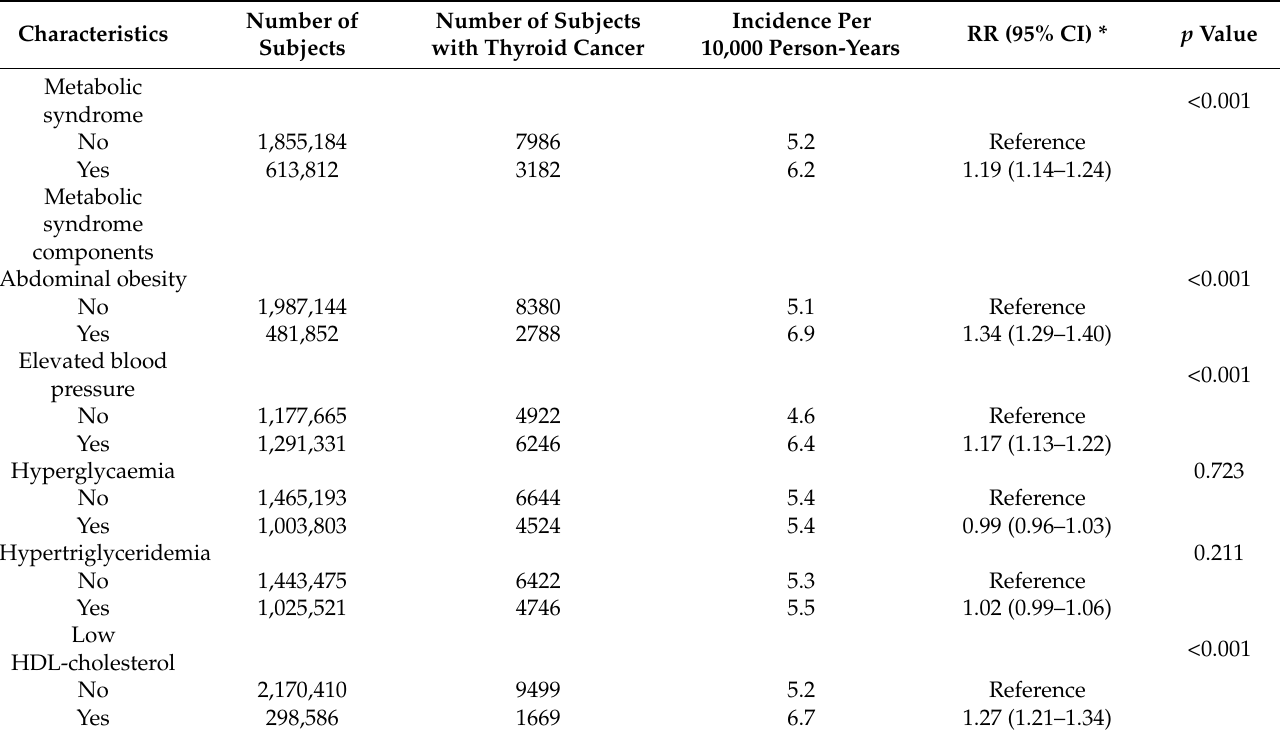
Table 2. Association of metabolic syndrome or its components with the risk of thyroid cancer in male participants.